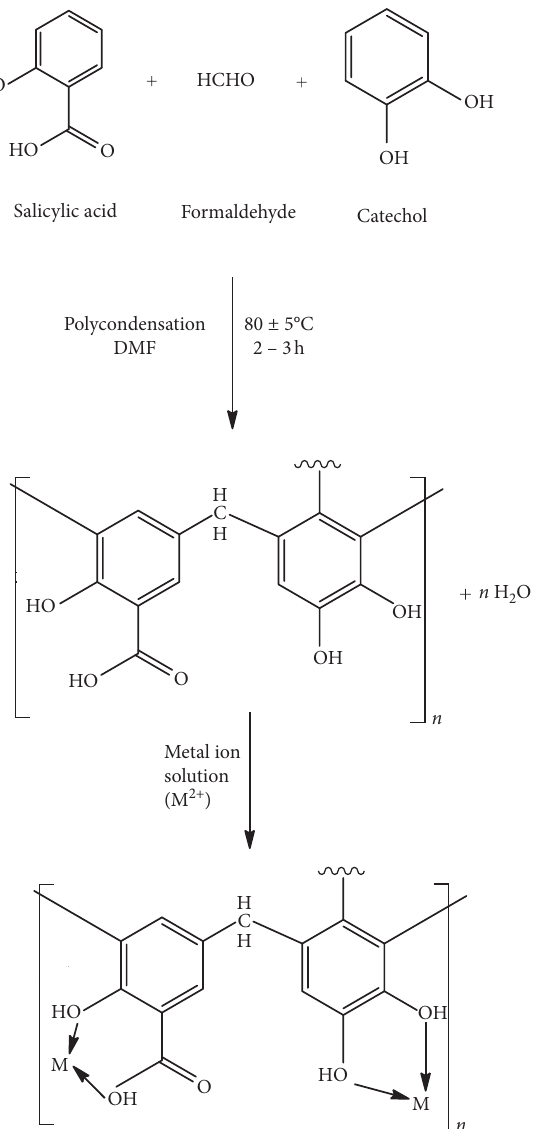
Figure 2: Reaction scheme of the SCF resin.